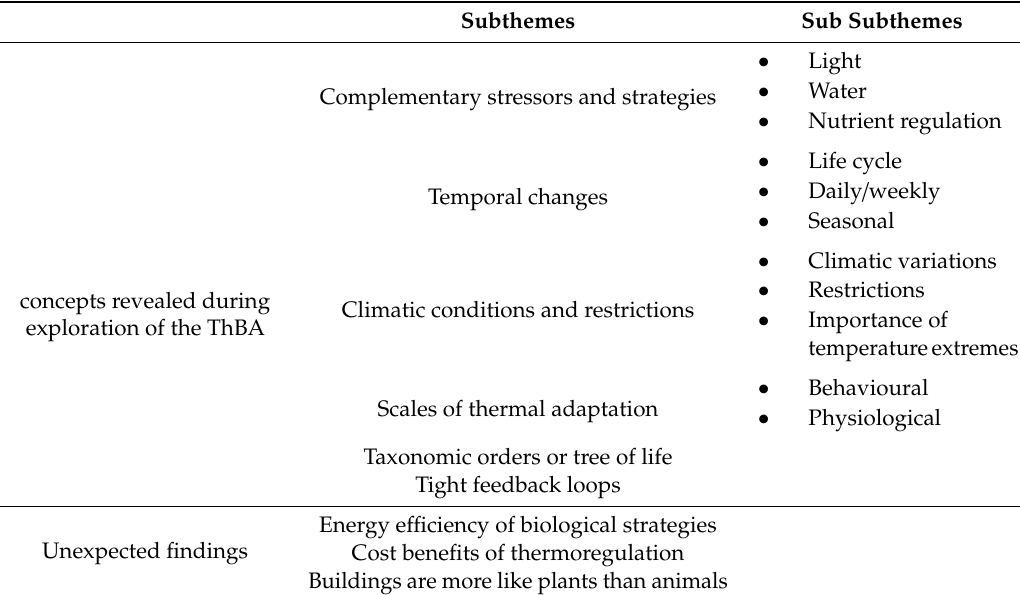
Table 4. Emergent subthemes from the third